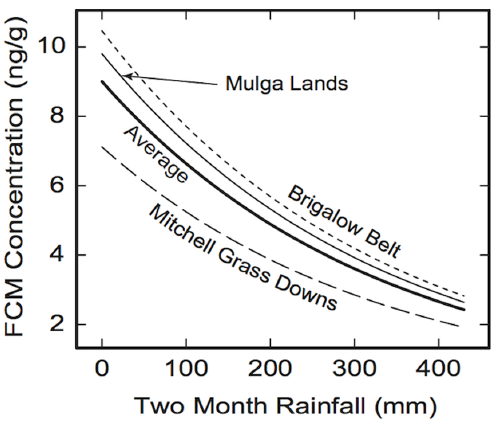
Figure 4. Regional variation in the relationship between faecal cortisol metabolite (FCM) concentration and rainfall during the two months before sample collection. The thick solid curve shows the cortisol levels averaged over all three bioregions combined (the same as the curve in Figure 3). The other three curves represent the average FCM levels for each of the bioregions: Brigalow Belt (small dashed curve), Mitchell Grass Downs (dashed curve), and Mulga Lands (thin solid curve). The total rainfall for the previous 4 months (months 3 to 6) is assumed to equal its average value of 310 mm.